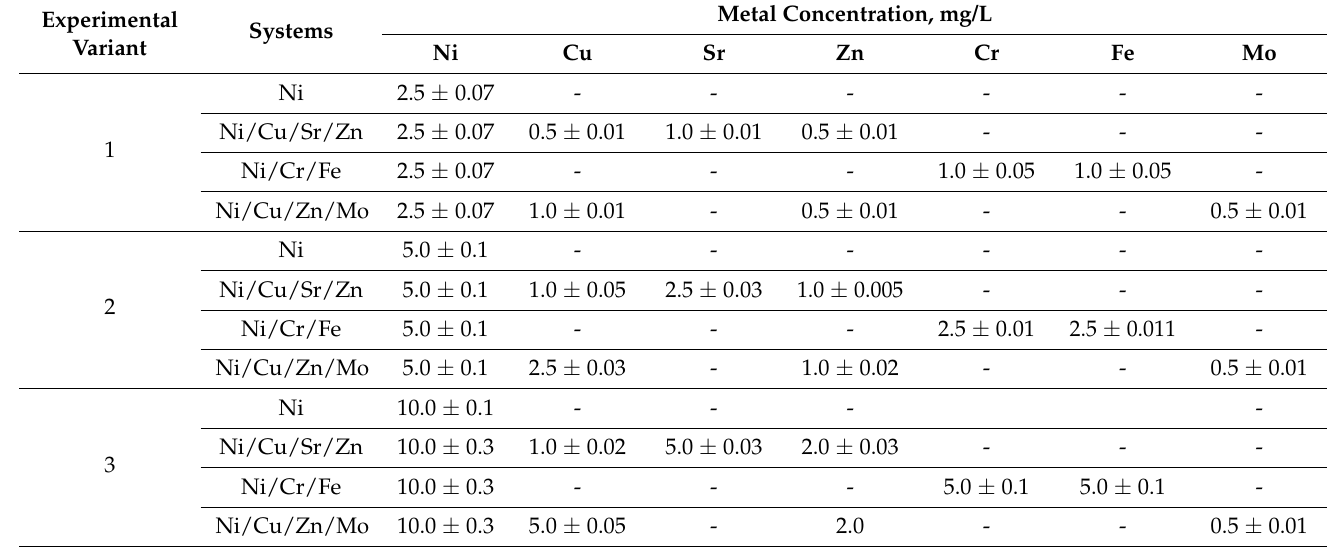
Table 1. Composition of synthetic